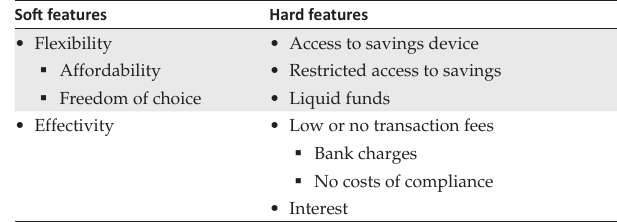
TABLE 4: Overview of results: Research question 3.